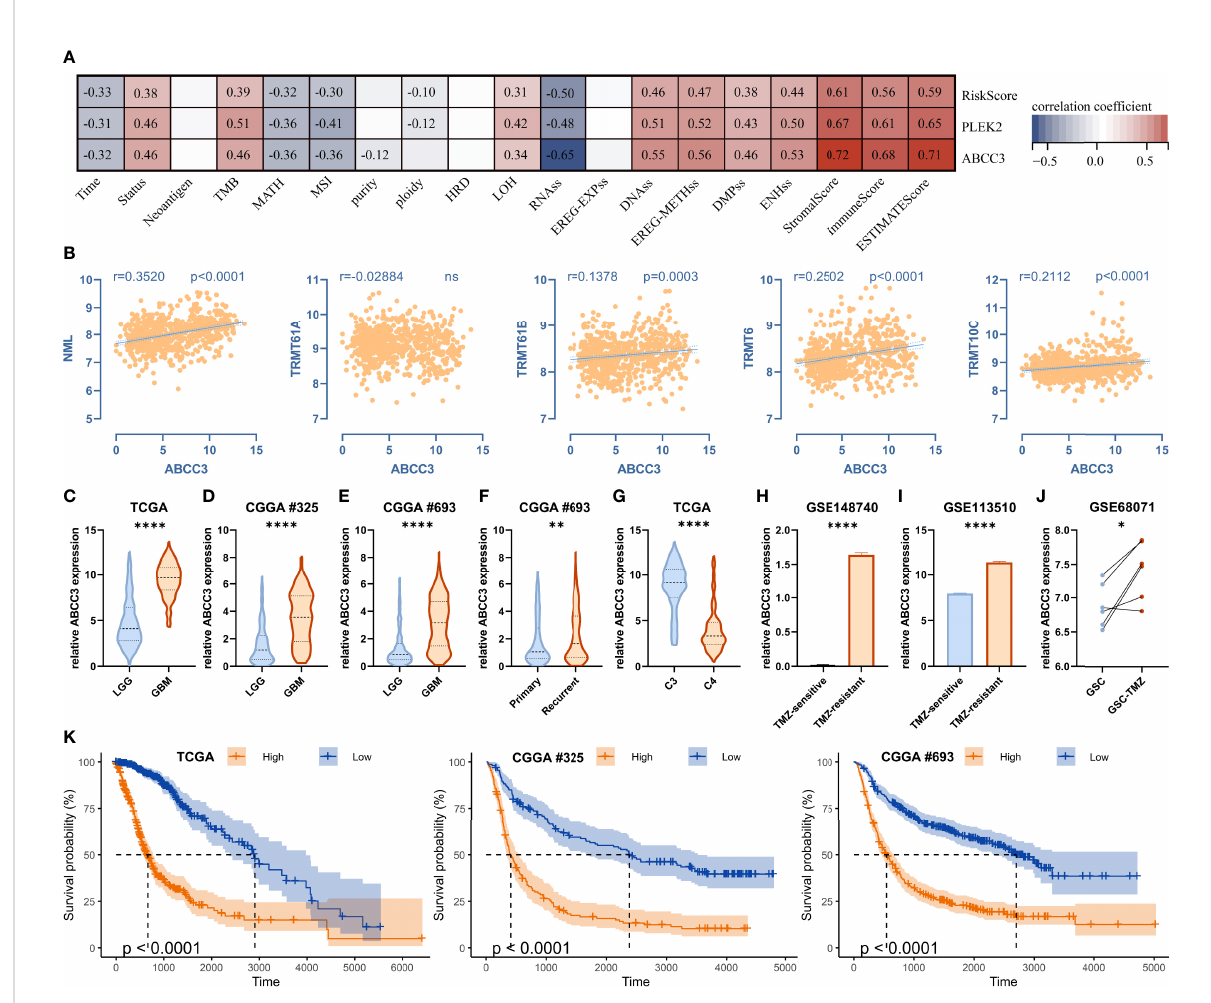
FIGURE 10 ABCC3 is associated with tumor stemness, genomic heterogeneity, immune microenvironment and TMZ-resistance. (A) Correlations between ABCC3 and tumor stemness, genomic heterogeneity, and immune microenvironment. (B) Correlation between ABCC3 and m 1 A regulators. (C – E) Differences in ABCC3 expression between LGG and GBM in TCGA, CGGA #325 and CGGA #693 cohort, respectively. (F) Differences in ABCC3 expression between primary and recurrent gliomas. (G) Differences in ABCC3 expression between cluster 3 and cluster 4 in the TCGA cohort. (H) Differences in ABCC3 expression between TMZ-sensitive and TMZ-resistant PDX models, (I) LN229 cells, and (J) GSC cells. (K) Kaplan-Meier curves displaying prognostic differences between ABCC3 high and low expression groups in the TCGA, CGGA #325, and CGGA #693 cohort, respectively. *, P < 0.05; **, P < 0.01; ****, P <